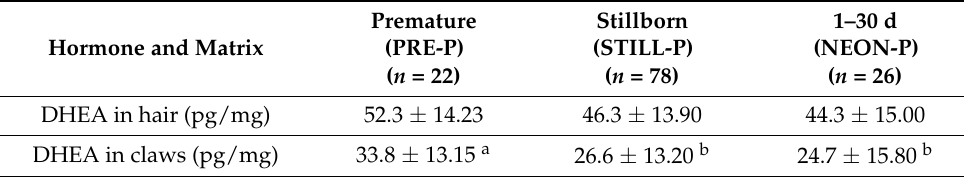
Table 2. Data (mean ± SD) about the hair and claw DHEA concentrations in the 126 puppies grouped ac-cording to the timing of death.